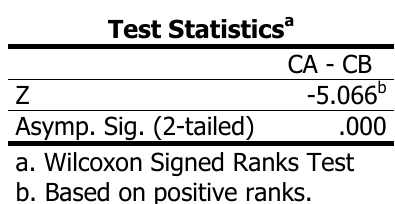
Table 6. Statistical Test of the Effect of Cultural Motivation after The Inauguration of the Garu-